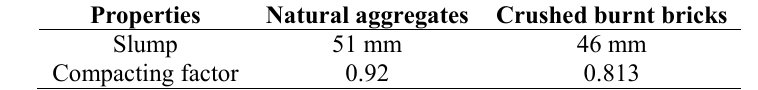
Fresh concrete properties.